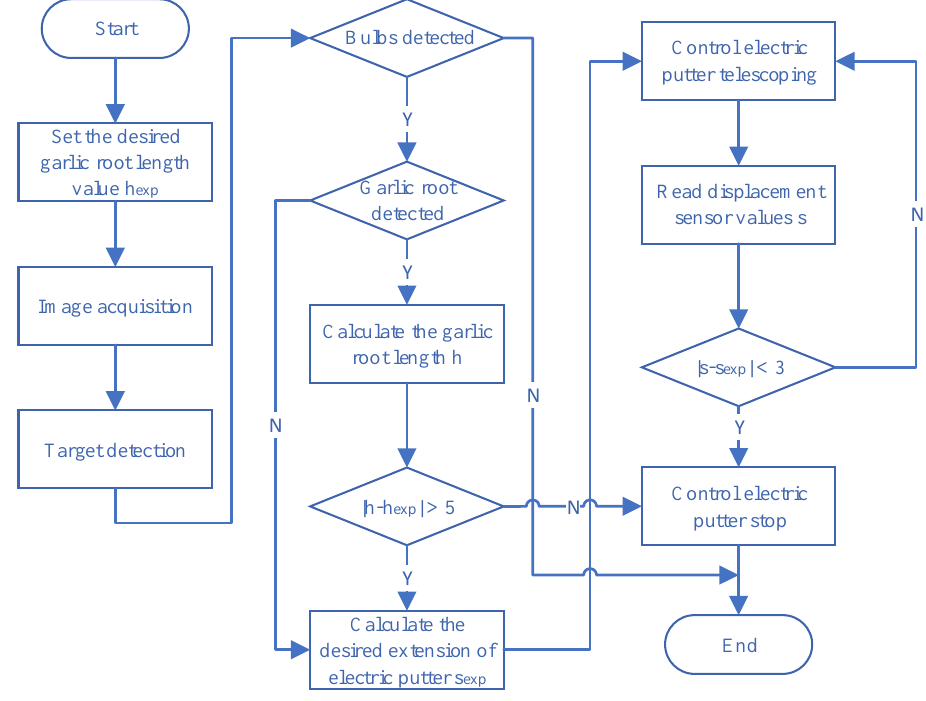
Figure 13. System control flow chart.